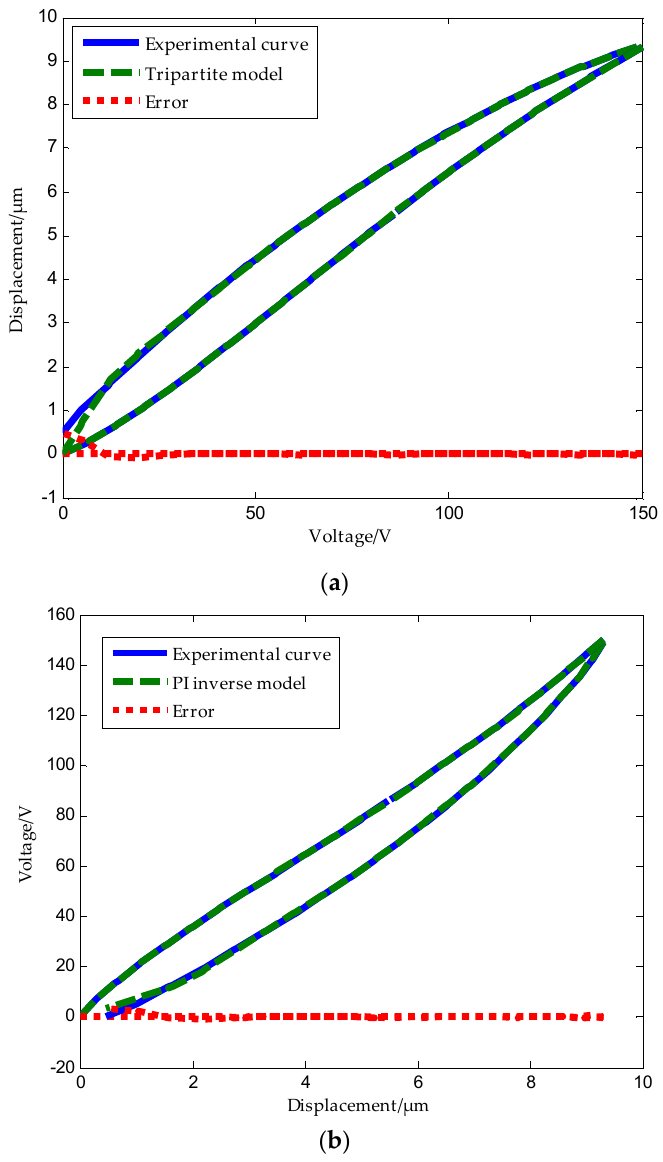
Figure 15. The tripartite PI model and its inverse model: ( a ) experimental and tripartite PI model hysteresis curves of a piezoelectric ceramic actuator; ( b ) experimental and tripartite PI inverse model hysteresis curves of a piezoelectric ceramic actuator.